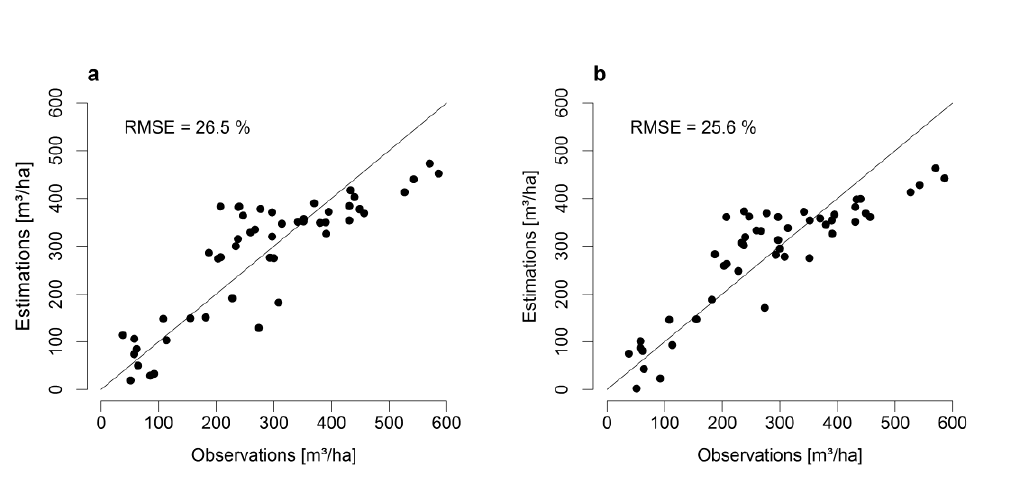
Figure 8. Estimated timber volume for EnMAP ( a ) and Sentinel-2 ( b ) in comparison to observed values on stand level, based on PLS-regression with all spectral